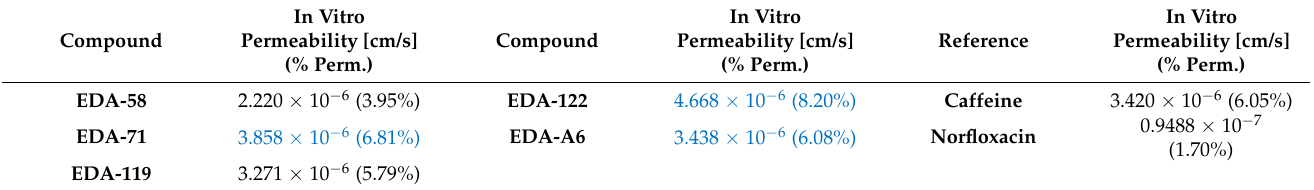
Table 2. Results of the experimental in vitro permeability test (PAMPA) for selected organic seleno- compounds, together with references with high or low permeability (caffeine or norfloxacin). The percentage of compound or reference that crossed from the donor well to the acceptor well (% Perm.) is shown in